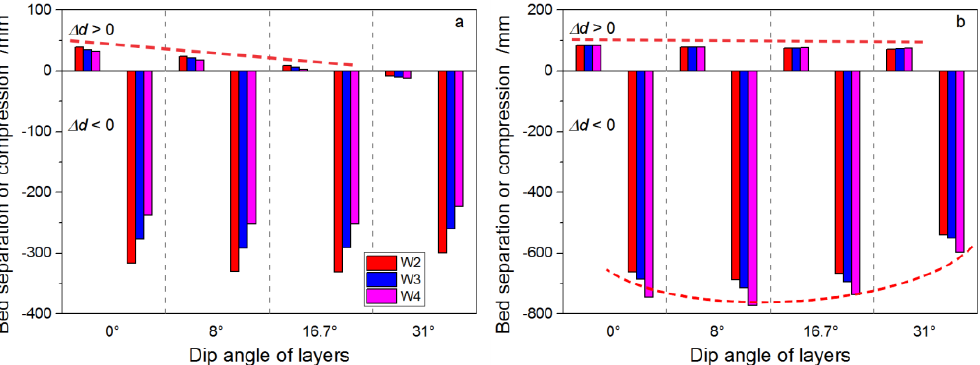
Figure 9. Extreme value statistics of bed separation and compression of well trajectories W2–W4 after the ( a) first panel is removed and then ( b ) second panels is removed sequentially in cases of various SDAs.